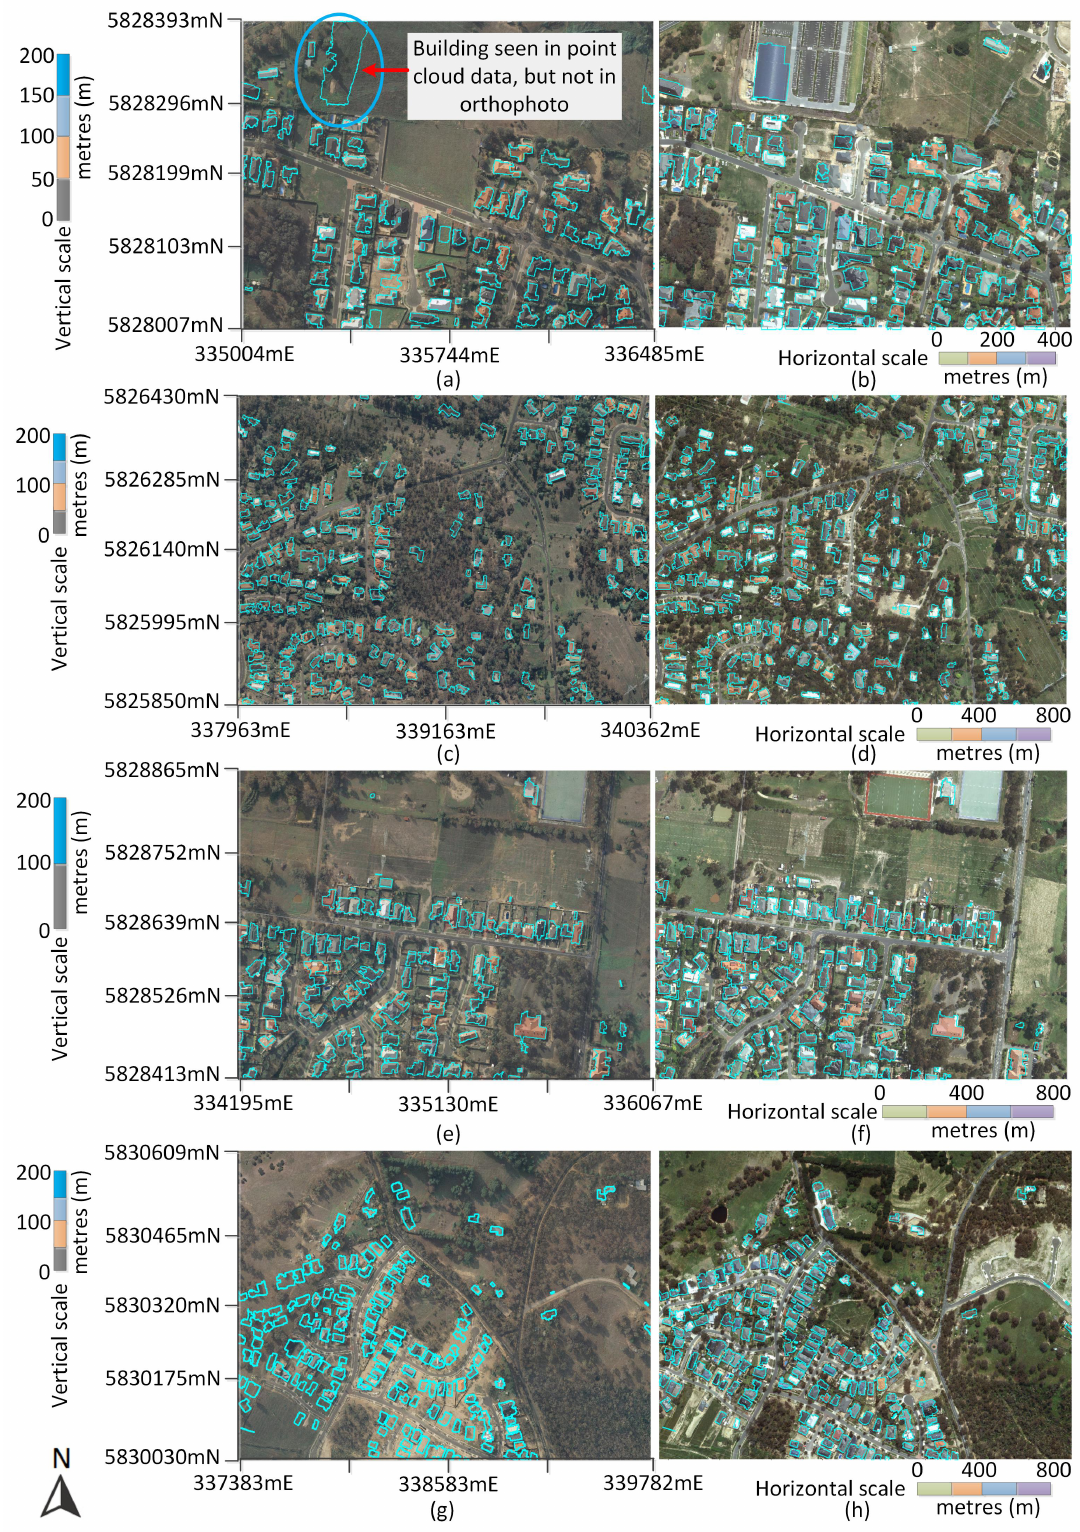
Figure 6. Automatic building detection in four scenes (overlaid on the orthophoto). The left column shows results from 2007 datasets and the right column from 2012 datasets. ( a , b ) Scene 1, ( c , d ) Scene 2, ( e , f ) Scene 3, and ( g , h ) Scene 4. The coordinates (easting (E), northing (N)) and scales shown for ( a ), ( c ), ( e ) and ( g ) are applicable to ( b ), ( d ), ( f ) and ( h ),